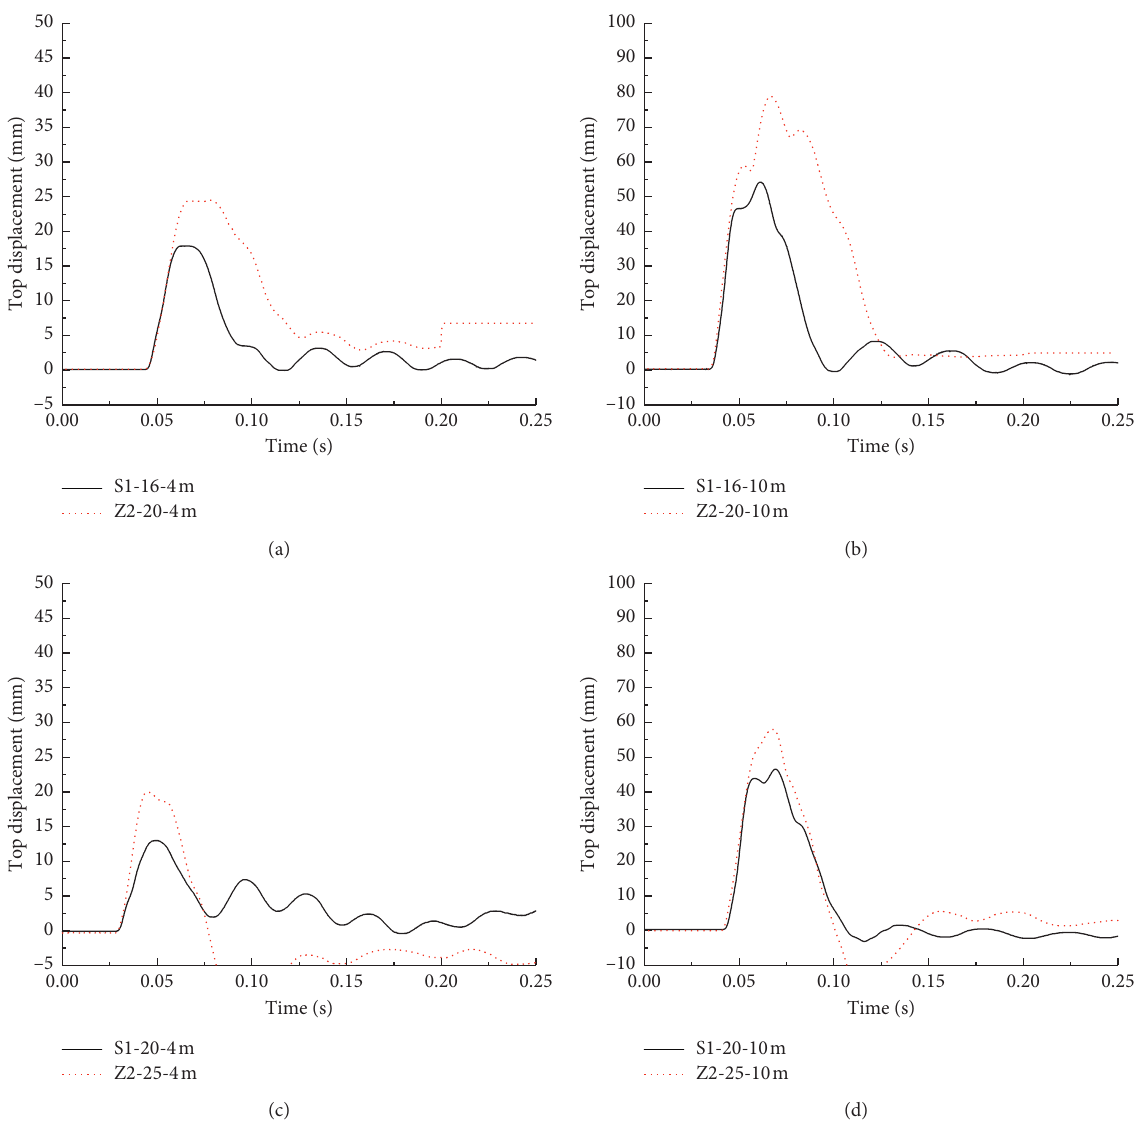
Figure 12: Time history curve of top displacement when the drop hammer is, respectively, lifted to 4m and 10m.